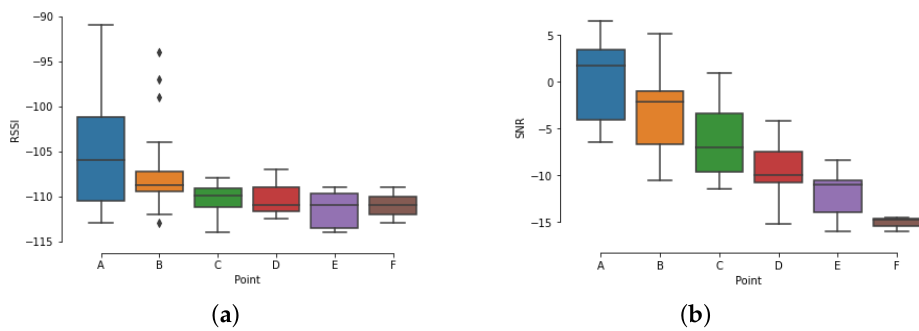
Figure 31. Average RSSI and SNR per LoRaWAN point. ( a ) RSSI. ( b ) SNR.